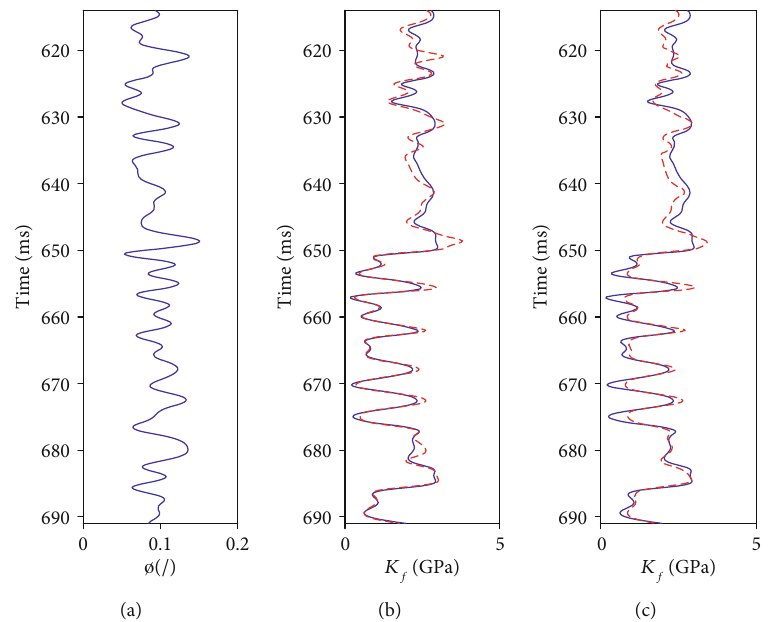
Figure 8: The comparison between the inverted fl uid modulus with our method and Zong et al. [26] from the noisy angle gather with S/N = 5 . The left subplot (a) displays the variation of porosity with time, the middle subplot (b) shows the inverted fl uid modulus with our method (red dashed line) and the true fl uid modulus (blue solid line), and the right subplot (c) shows the inverted fl uid modulus with the method of Zong et al. [26] (red dashed line) and the true fl uid modulus (blue solid line).